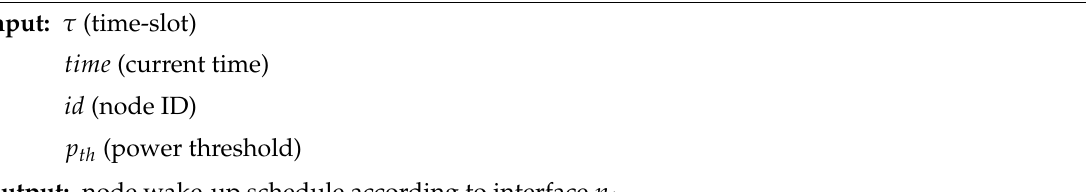
Algorithm 1 COPE—Run at each